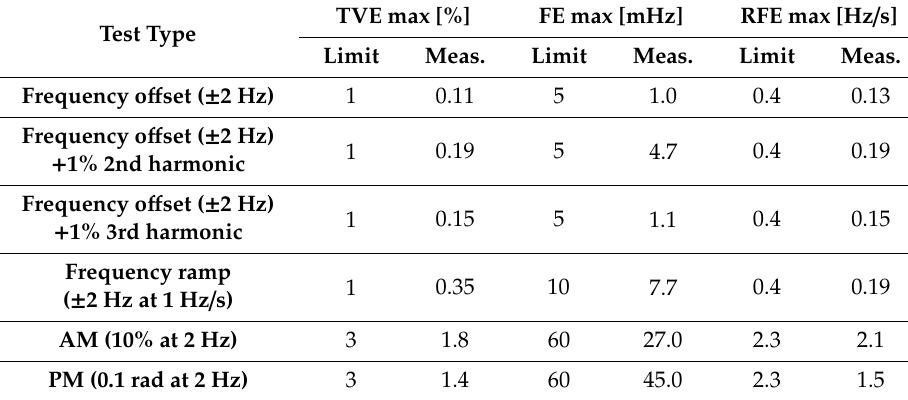
Table 1. Maximum measured (Meas.) TVE, FE and RFE, and the corresponding limit values, in various testing conditions reported in IEEE Standards for Class P PMUs. The reported results refer to observation intervals of four nominal cycles and reporting rate of 50 fps.